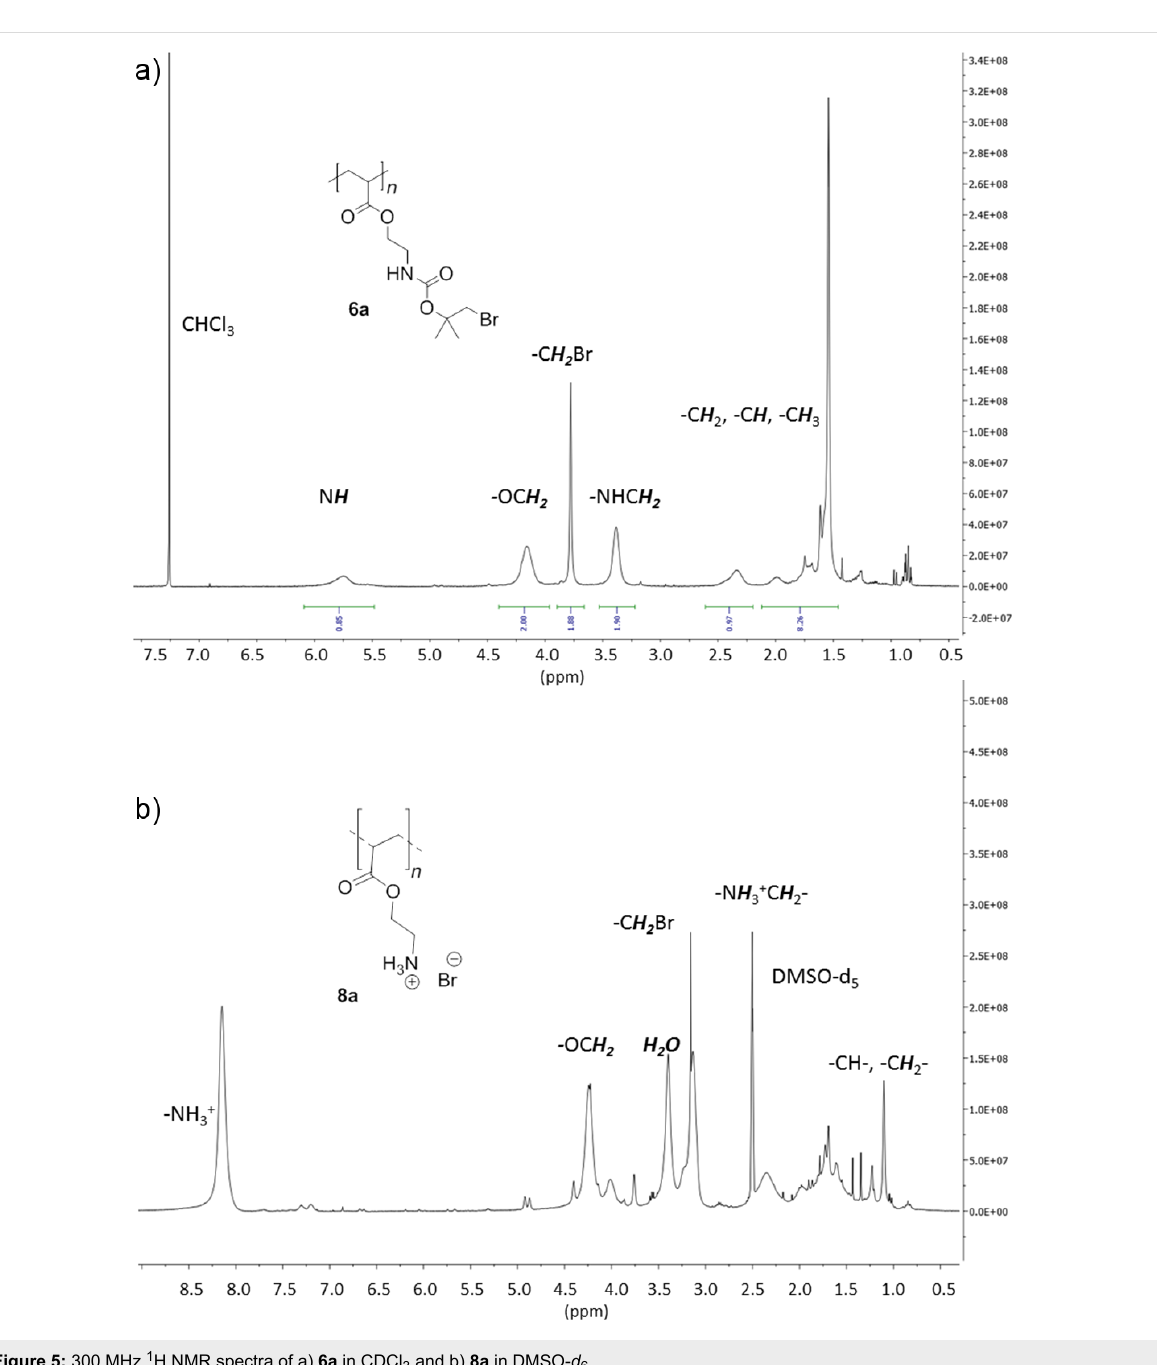
formation infrared spectroscopy (FTIR) was performed on a Nicolet 6700 FTIR spectrometer equipped with a diamond single bounce ATR accessory. The measurements were per- formed in the range of 400–3000 cm − 1 at room temperature. Differential scanning calorimetry (DSC) was performed using a Mettler Toledo DSC 822 instrument equipped with a sample robot TSO801RO. The Apparatus was controlled over a temper- ature range between − 50 °C and 350 °C at a heating rate of